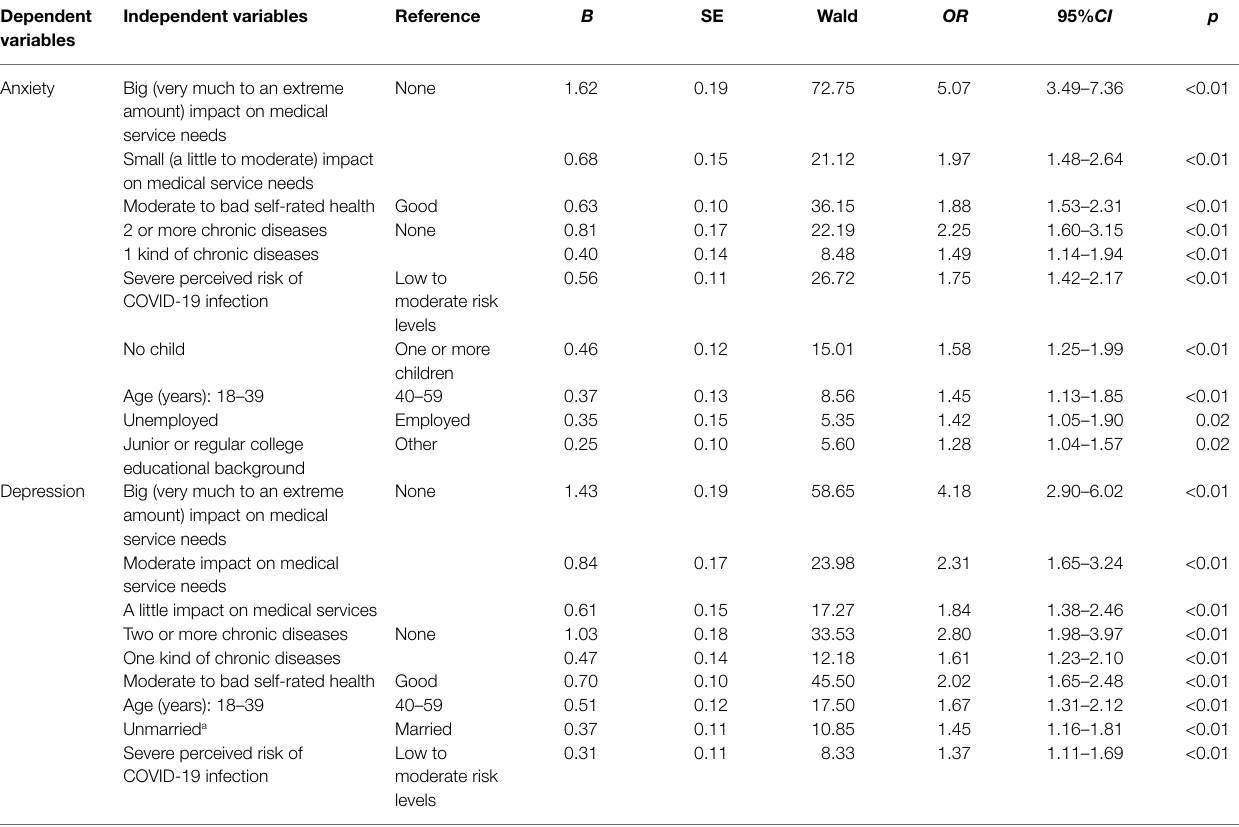
TABLE 4 | Multivariate logistic analysis of anxiety and depression of the adult, working-age population in Mainland China in the COVID-19 pandemic. Dependent Independent variables